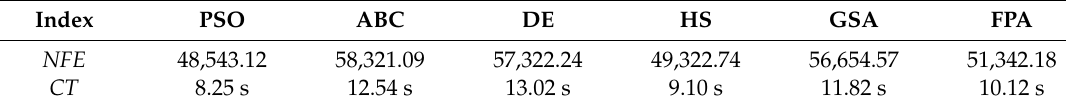
Table 3. Averaged measurements corresponding to the number of function evaluations ( NFE ) and the computing time ( CT ) spent by each method obtained from 20 independent executions.